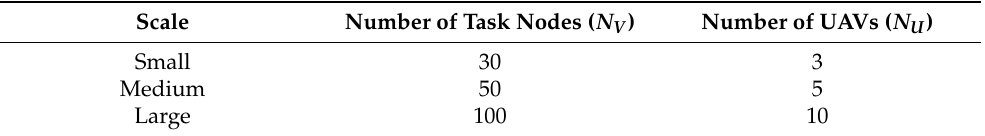
Table 1. Parameters of